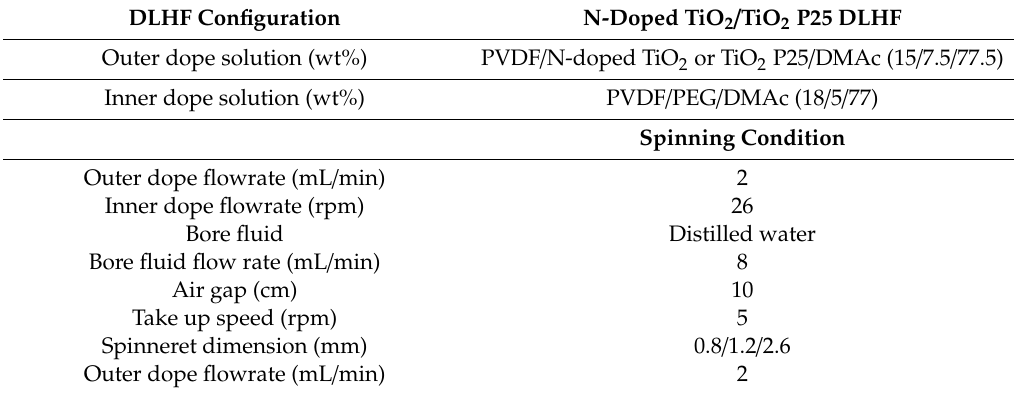
Table 1. Dope compositions and spinning conditions of the dual-layer hollow fiber (DLHF) membranes